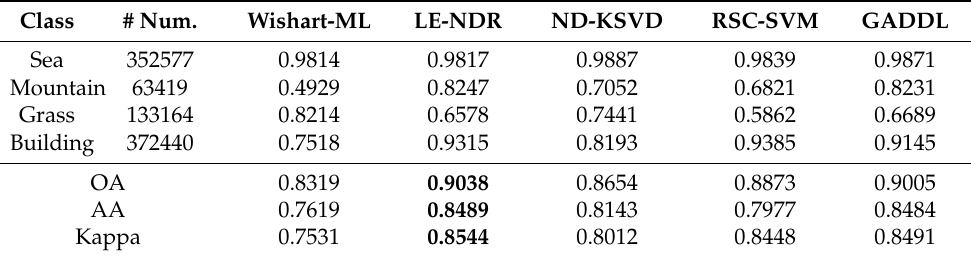
Table 2. The overall accuracy (OA), average accuracy (AA) and kappa coefficient values of different methods on the SanFransco image. # Num. denotes the number of samples of each category. Class #